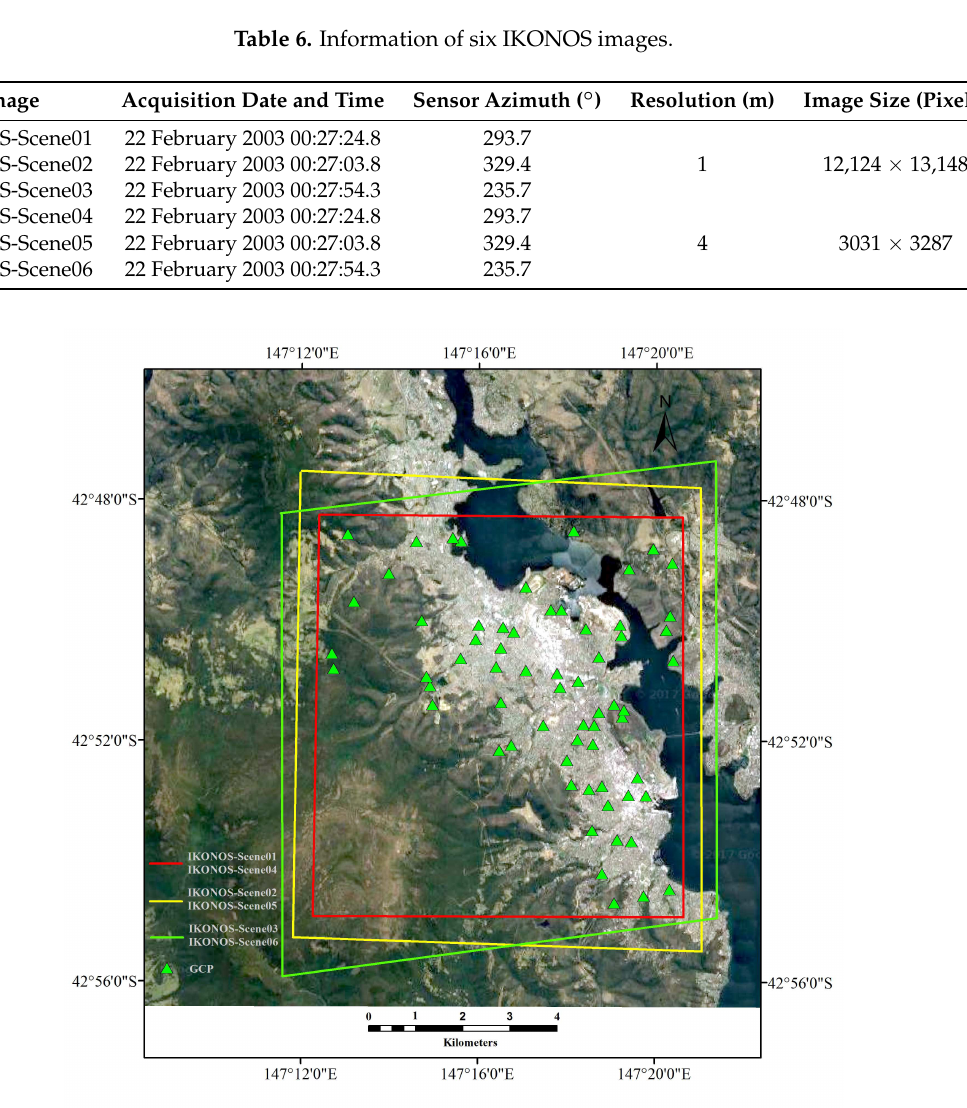
Figure 4. The extents of 6 IKONOS images in Australia and the GCPs distribution (The background map is downloaded from the Google